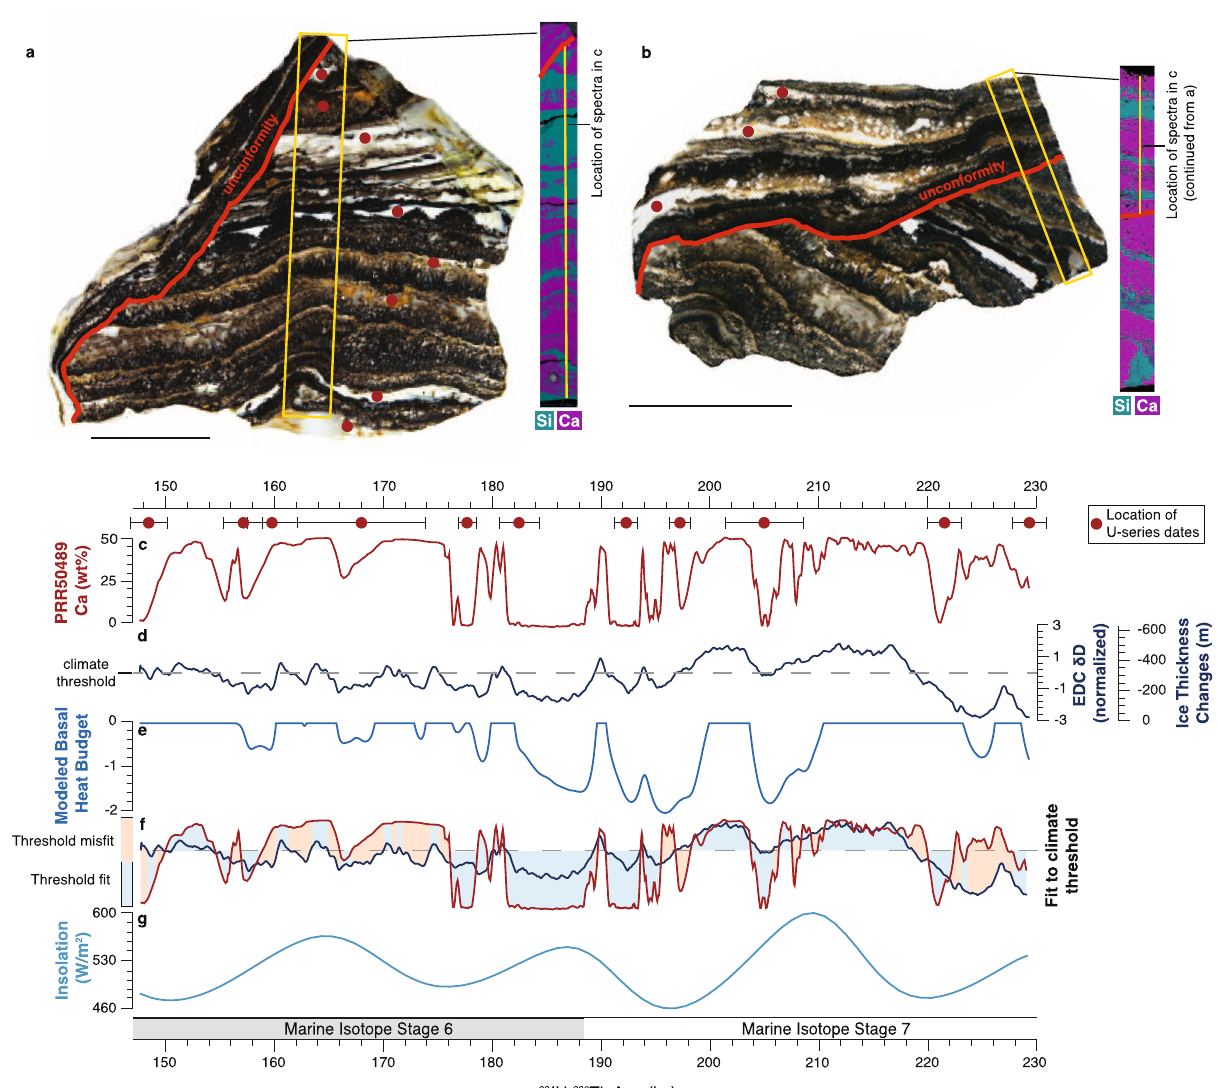
Fig. 3 | Sample PRR50489 SEM-EDS image and comparison to climate records. a Slab and SEM-EDS image of sample PRR50489. b Slab and SEM-EDS image of second piece of sample PRR50489. This piece of sample includes material above angular unconformity. Scale bars are 1cm. c Ca concentration of sub- glacial precipitate sample PRR50489. High values represent calcite precipita- tion; low values represent opal precipitation. U-series dates include 2 σ uncertainties bars. d δ D measured in EPICA Dome C Ice Core (EDC) 109,110 .